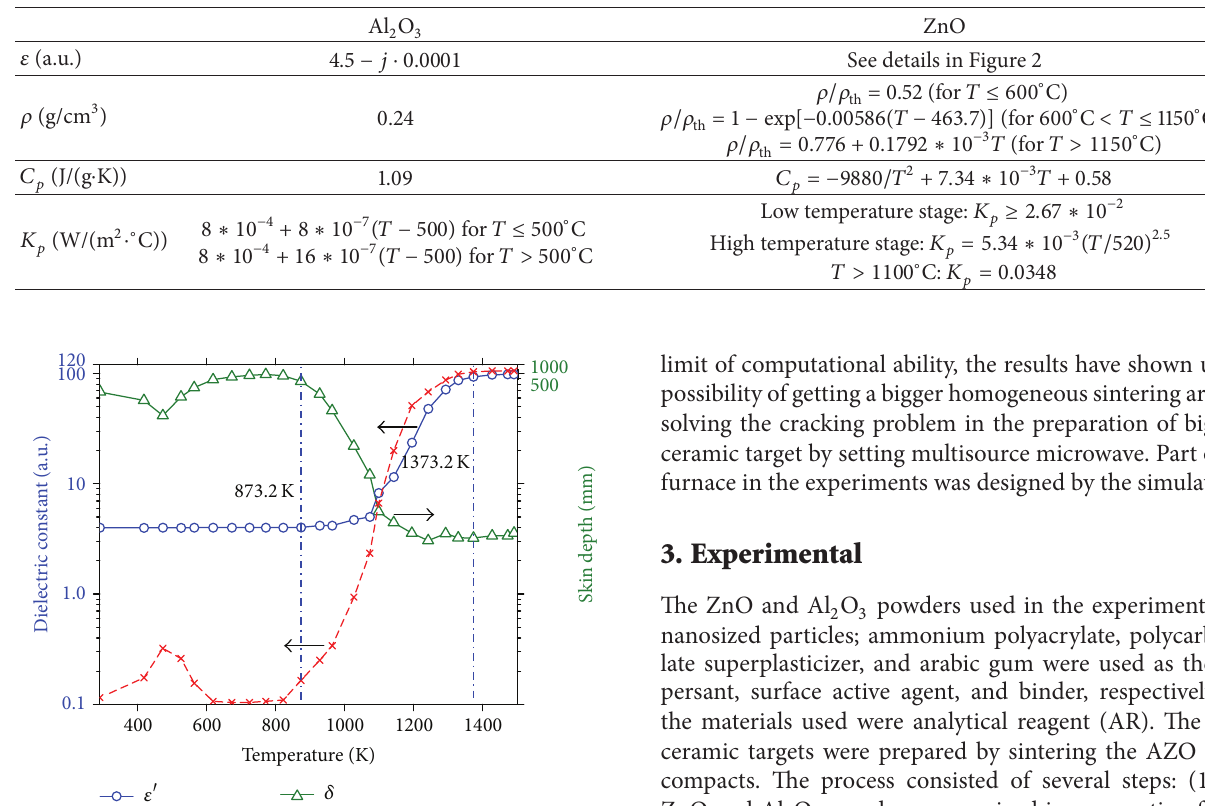
Table 1: Relevant parameters of ZnO and Al 2 O 3 .